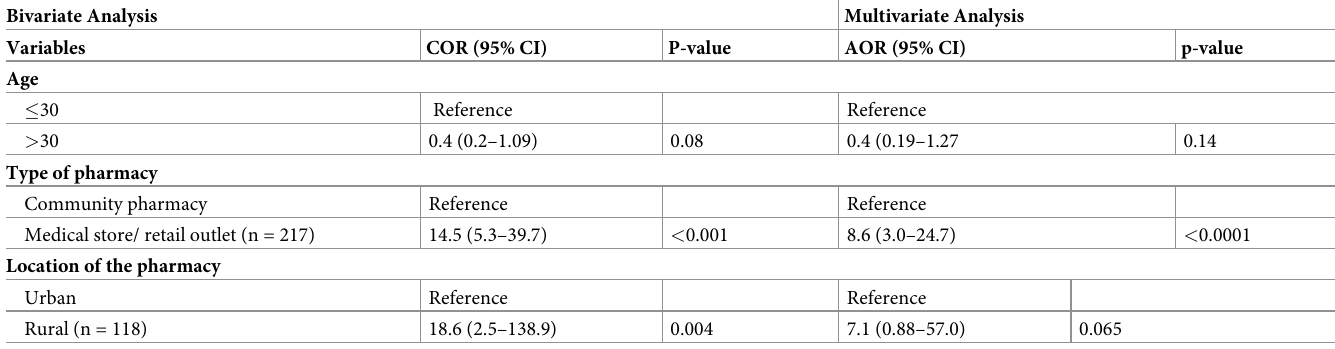
Table 3. Bivariate and multivariate analysis with independent and antibiotic dispensing without prescription. Bivariate Analysis